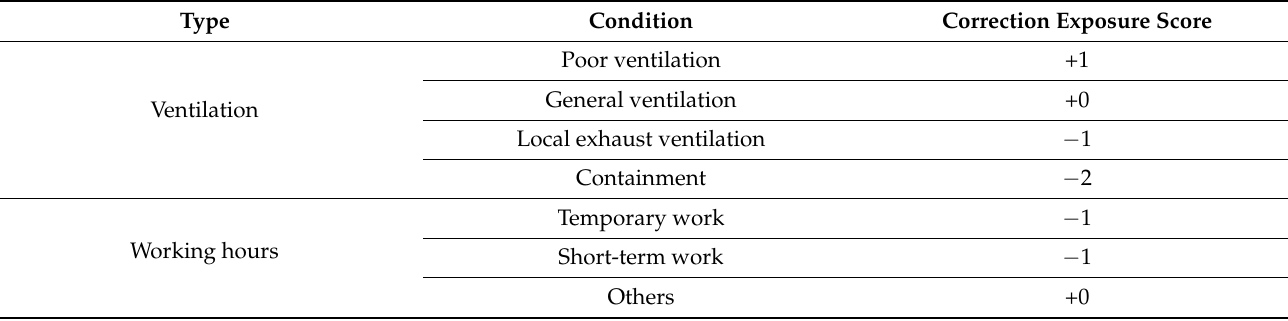
Table 5. Correction of exposure scores according to ventilation condition and working hours.